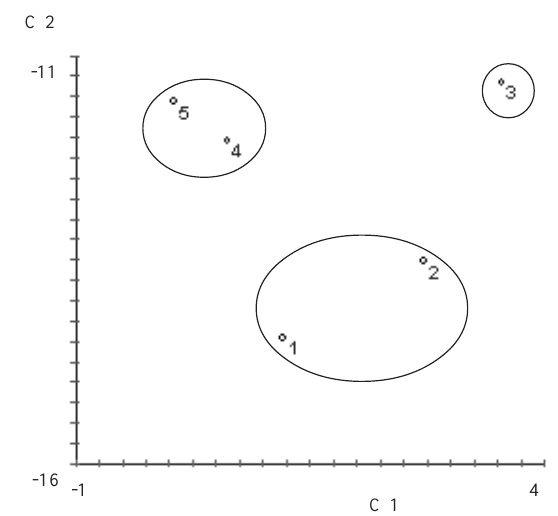
Figura 6. Dispersão gráfica das coberturas vegetais em relação aos dois primeiros componentes principais, com base nas variáveis da serapilheira na época do verão. 1- Eucalipto, 2-